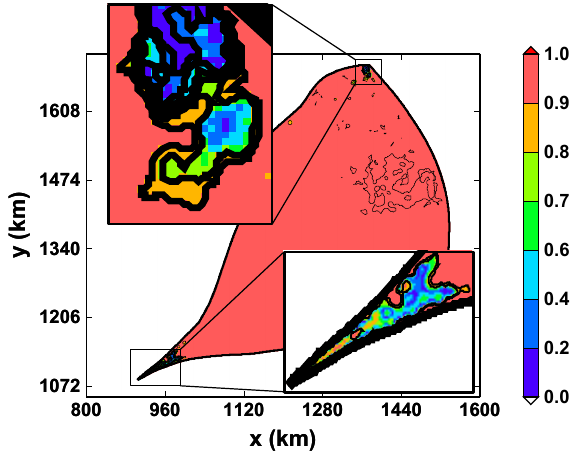
q τ 2 xz + τ 2 yz /σ e computed at the ice base Figure 8. Stress ratio ς = for the constant-climate control run CTL with